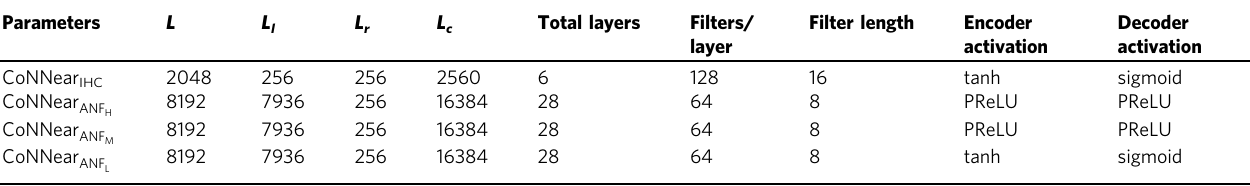
Table 1 Final parameter selection of the CoNNear